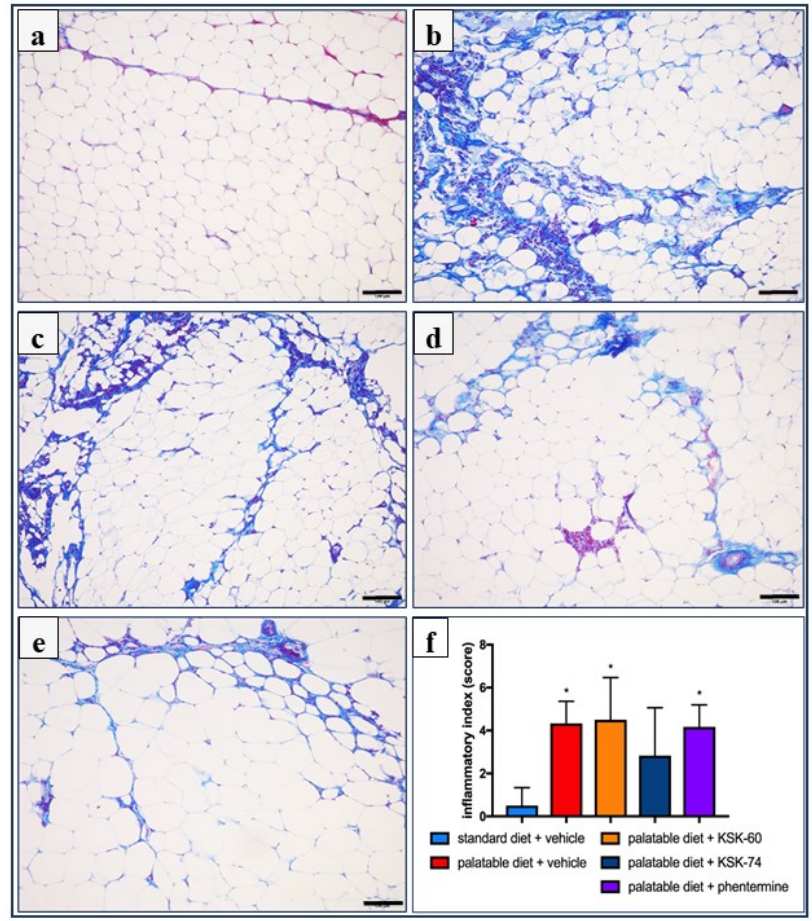
Figure 8. Representative histological pictures of Masson’s trichrome-stained adipose tissue sections (bar = 100 mm). ( a ) Standard diet + vehicle group, ( b ) palatable diet + vehicle, ( c ) palatable diet + KSK-60 10 mg/kg, ( d ) palatable diet + KSK-74 10 mg/kg, ( e ) palatable diet + phentermine 7 mg/kg. Many inflammatory cells infiltrating the area of the adipocytes and trichrome-positive fibrotic streaks are visible in the adipose tissue of all studied groups, except the rats in the standard diet + vehicle group. ( f ) Inflammatory index expressed as means ± SD, n = 6. Comparisons were made using the Kruskal–Wallis test followed by the Dunn post hoc test; * significant vs. standard diet + vehicle group; * p <